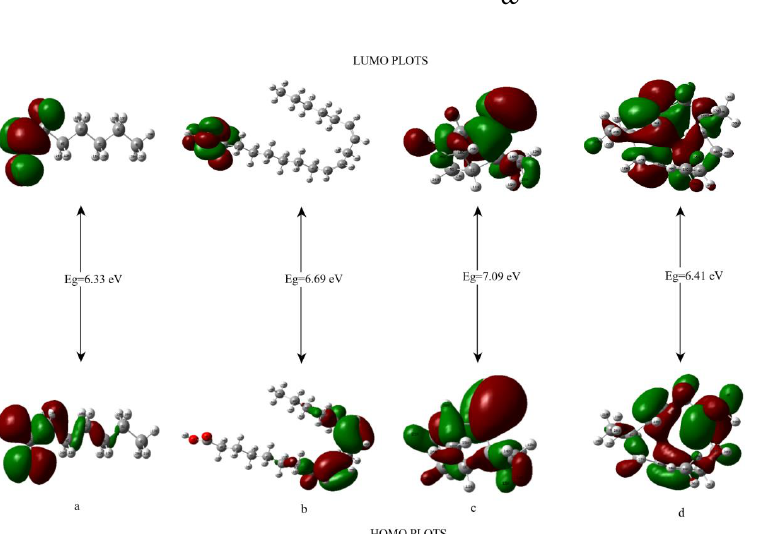
Figure 3. Three-dimensional HOMO LUMO orbital diagram of the studied molecules ( a – d ). The smaller the energy gap, the more reactive and less stable that molecule [33], and according to these values, we can say that the most reactive molecule is the 1st molecule